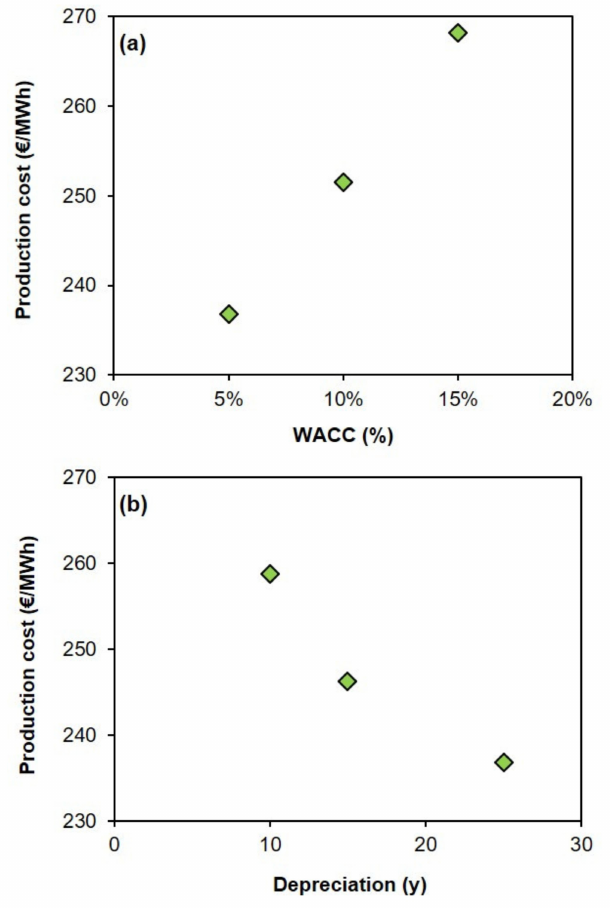
Figure 5. Effects of varying ( a ) WACC and ( b ) depreciation on the fuel production cost.